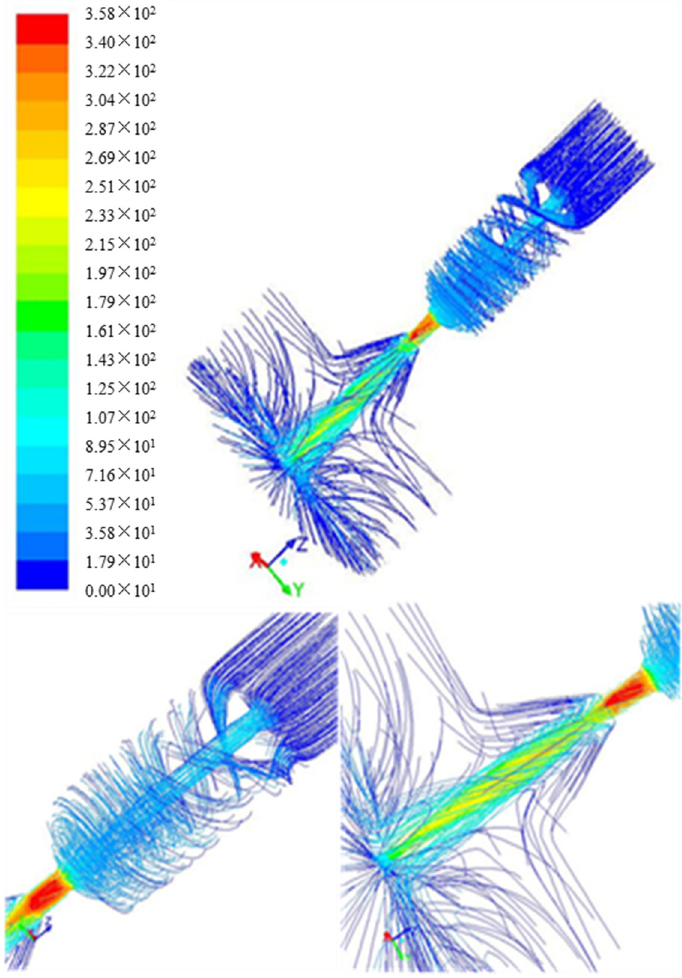
Figure 4. The streamlines of swirling-round SC-CO 2 jet flow.